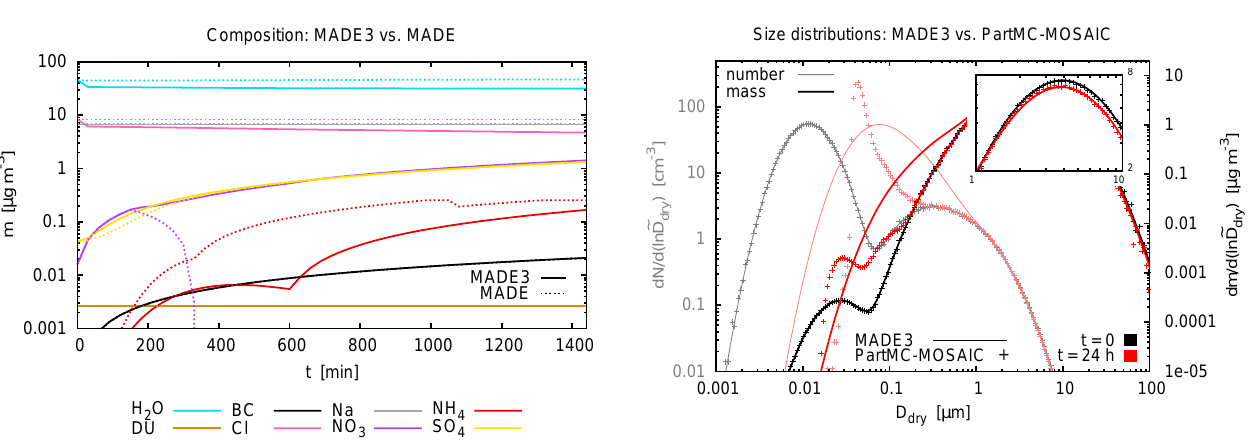
Figure 4. Temporal evolution of total aerosol species mass concen- trations in MADE3 (solid lines) and MADE (dotted lines). Abbre- viations are as follows: BC for black carbon and DU for mineral dust. Note that the particulate organic matter (POM) concentration is below 0 . 001µgm − 3 and therefore does not appear in the plot.